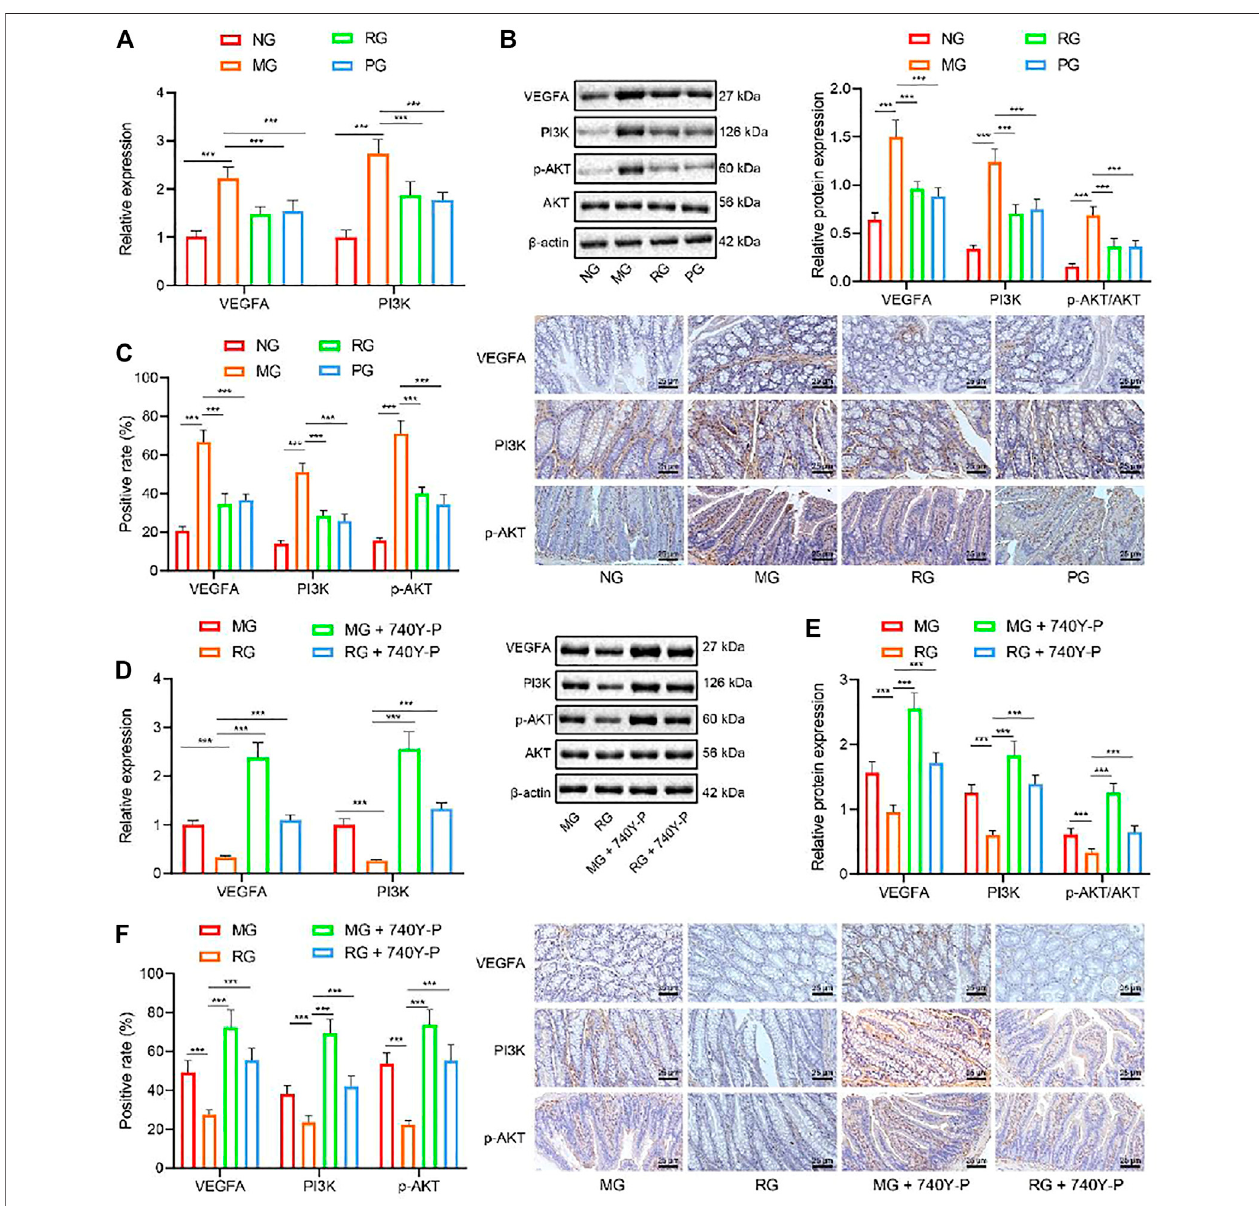
FIGURE 3 | RSV inhibits the PI3K/Akt pathway activation and reduces the VEGFA gene expression. (A) The expression of VEGFA and PI3K and genes in colon tissueswereanalyzedbyRT-qPCR. (B) TheexpressionofVEGFA,PI3K,p-Akt,andAktproteinincolontissueswasdetectedbyWesternblotanalysis. (C) Expressionof VEGFA and Akt protein in colon tissues was analyzed by IHC. (D) The expression of VEGFA and PI3K in colon tissues after the addition of PI3K/Akt activator was determined with RT-qPCR. (E) Western blot analysis of the expression of VEGFA, PI3K, and p-Akt/Akt ratio was in colon tissues after the addition of PI3K/Akt activator. (F) The expression of VEGFA and p-Akt protein in colon tissue after adding PI3K/Akt activator was determined with IHC. # p < 0.05 vs. VEGFA, PI3K, and Akt expression in MG. ## p < 0.01. n 20. Measurement data were expressed by mean ± SD. One-way ANOVA was conducted for multiple group comparison, followed by Tukey ’ sposthoctest.NG,normalcontrolgroup;MG,modelcontrolgroup;RG,resveratrolgroup;PG,positivecontrolgroup;VEGFA,vascularendothelialgrowthfactor A; 740Y-P, PI3K/Akt activator.